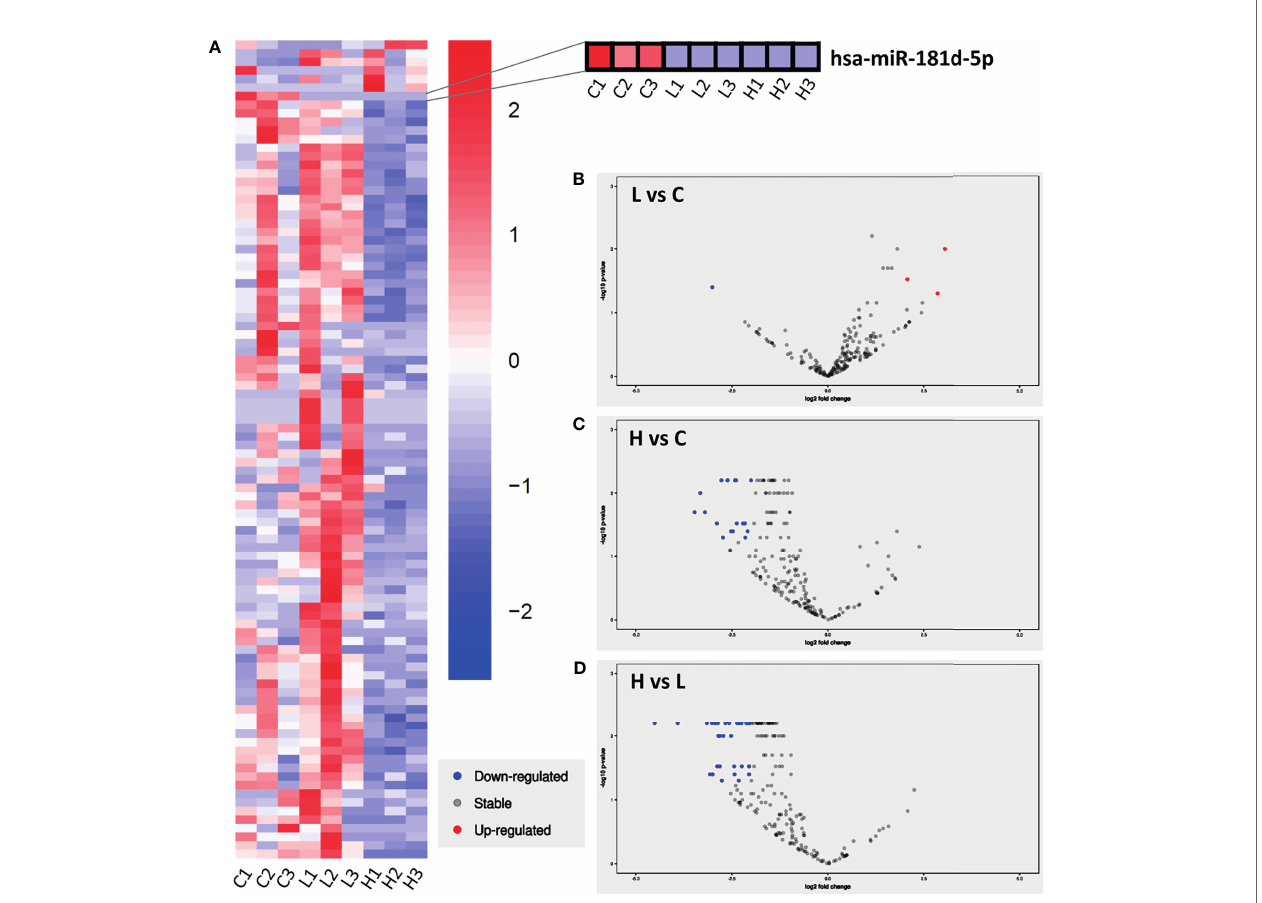
FIGURE 2 | Expression pro fi le of miRNAs found in LSG from SS-patients and sicca controls using NGS. (A) Heat map of differentially expressed miRNAs in LSG from sicca controls (C) and SS-patients with low (L) and high (H) focus score (FS). The rows of the heat map represent miRNAs, while the columns represent different LSG samples. A zoom to the hsa-miR-181d-5p is displayed. (B-D) Volcano plots of miRNAs down-regulated (blue dots), up-regulated (red dots) or stable (grey dots) found in LSG from SS-patients with low (L) FS, compared to sicca controls (B) ; high (H) FS, compared to sicca controls (C) ; and low (L) FS, compared to high (H) FS (D) . The fi lter used was Log2FC=|2| and p-value ≤